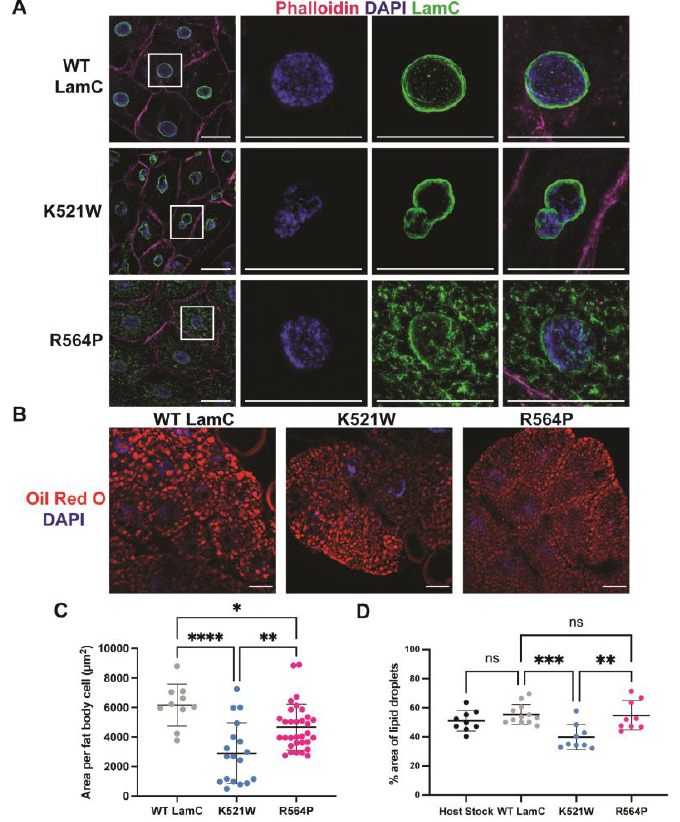
Figure 6. LamC K521W and R564P cause nuclear and cytoplasmic abnormalities in larval fat body tissue. ( A ) Larval fat body tissue expressing either wild-type or mutant LamC were stained with phalloidin (magenta), DAPI (blue), and antibodies to LamC (green). Note that LamC K521W localizes to the nuclear envelope and causes nuclear lobulations. By contrast, LamC R564P localizes within the cytoplasm and the nucleus remains spherical. ( B ) Larval fat body tissue expressing either wild-type or mutant LamC were stained with Oil Red O and DAPI. Scale bar represented 30 µ m. ( C ) The average area per adipose cell for each genotype was determined and plotted. Note the reduced size of the fat body cells expressing LamC K521W compared to that of the control. ( D ) The percent area of lipid droplets was calculated and plotted. Three fat bodies from three larvae of similar age were analyzed per genotype. Error bars represent the standard deviation of the mean.